Question: Briefly state, in one sentence, what is plotted here.
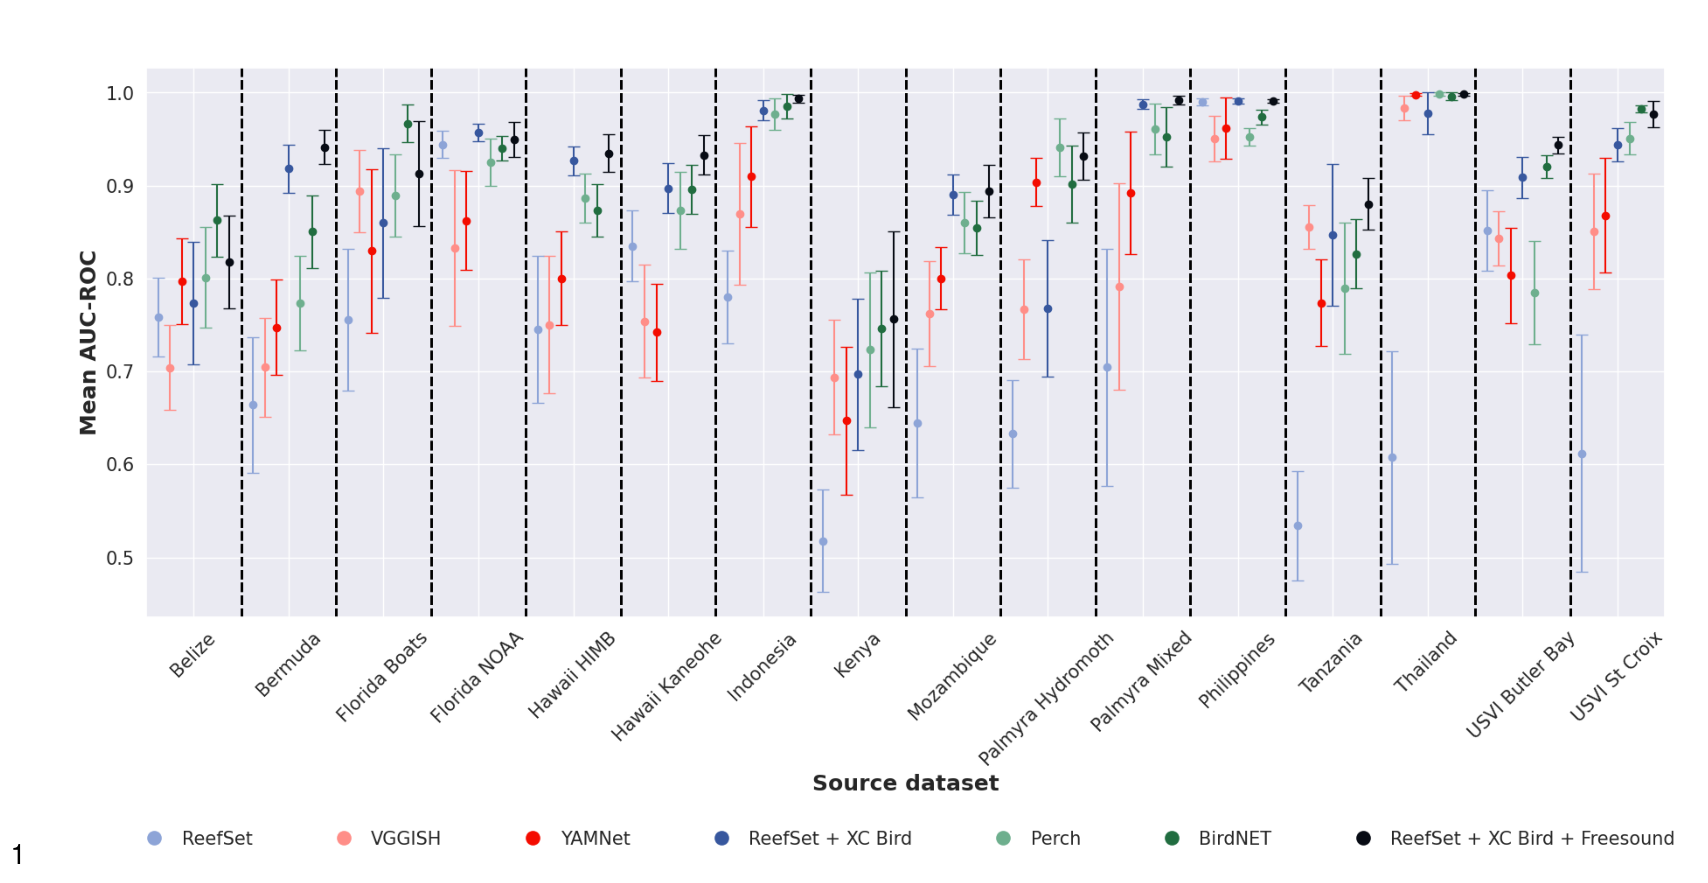
Answer: Mean AUC-ROC scores reported by transfer learning evaluation on each dataset within ReefSet across all training samples per class counts  2